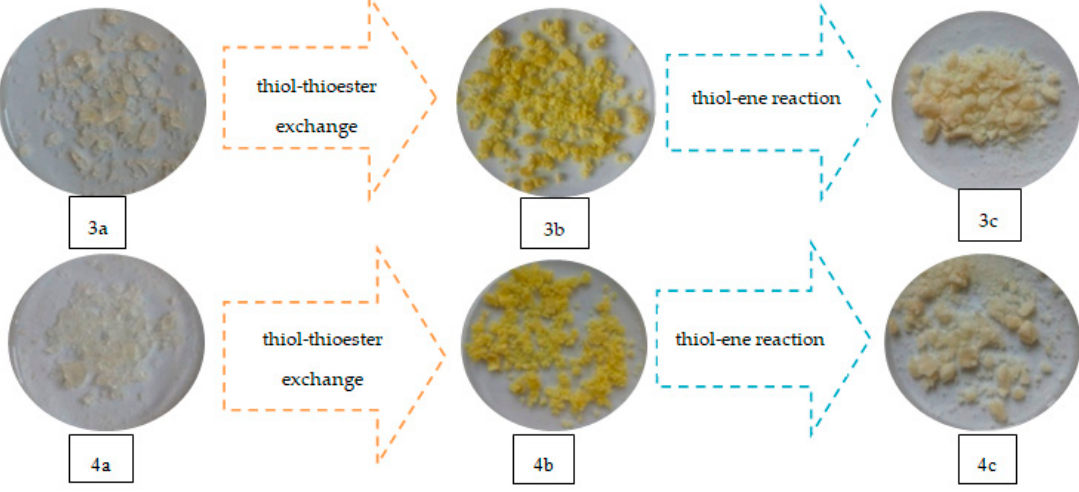
Figure 17. ImagesofmaterialsobtainedwithST(3a–c)andMMA(4a–c)copolymerswith1,4(1,5)-NAF-CH 2 Figure 17. Images of materials obtained with ST (3a–c) and MMA (4a–c) copolymers with 1,4(1,5)-NAF-CH 2 S-Met.